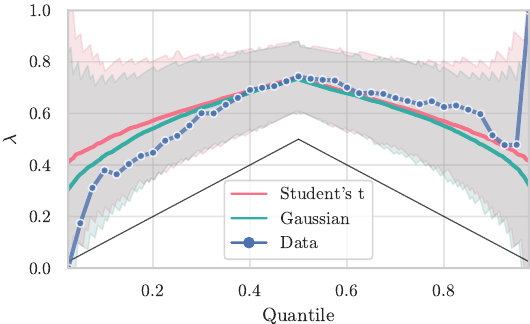
Figure 3. Quantile dependence ˆ λ of the estimated copulas, together with corresponding 95% confidence intervals (depicted as shaded